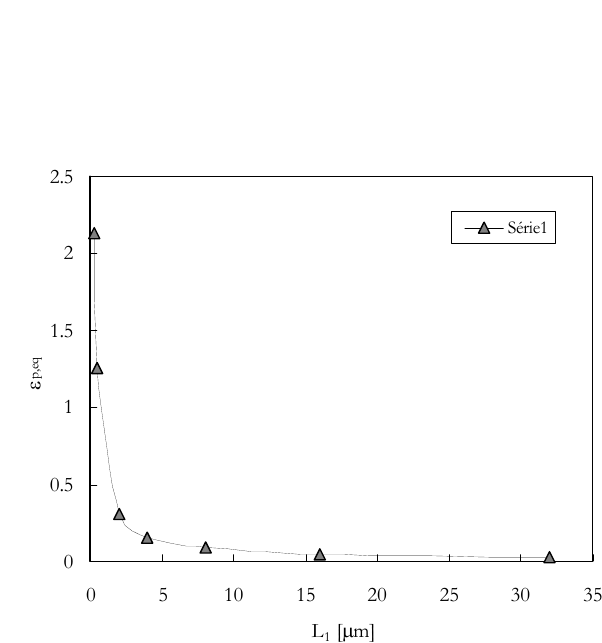
Figure 6: Effect of mesh refinement on maximum equivalent plastic